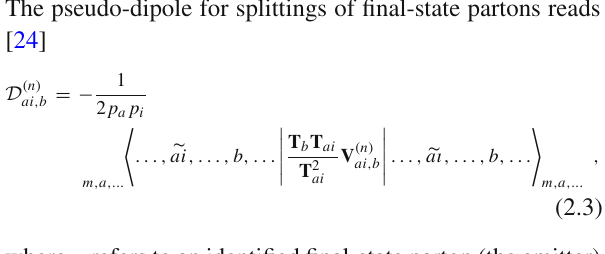
CS − momenta mapping